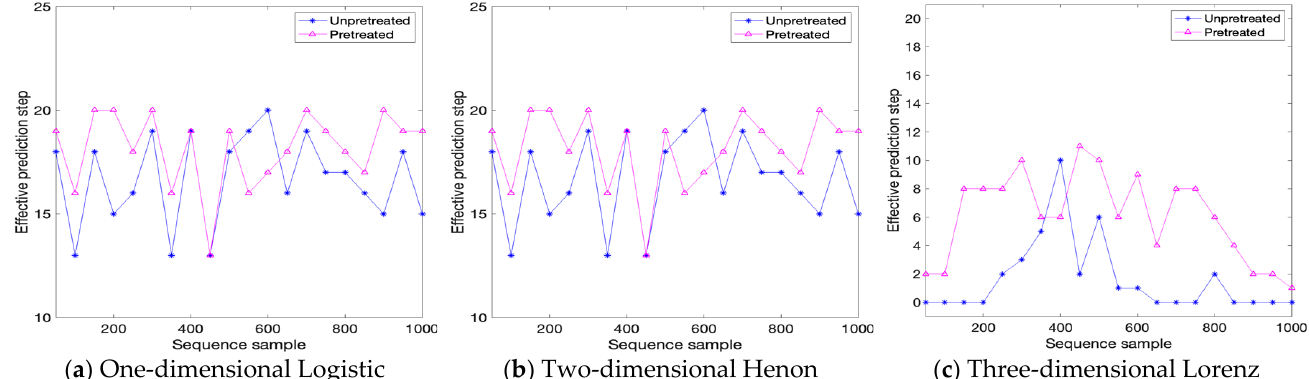
Figure 2. Test results of the ILTP preprocessing stage.